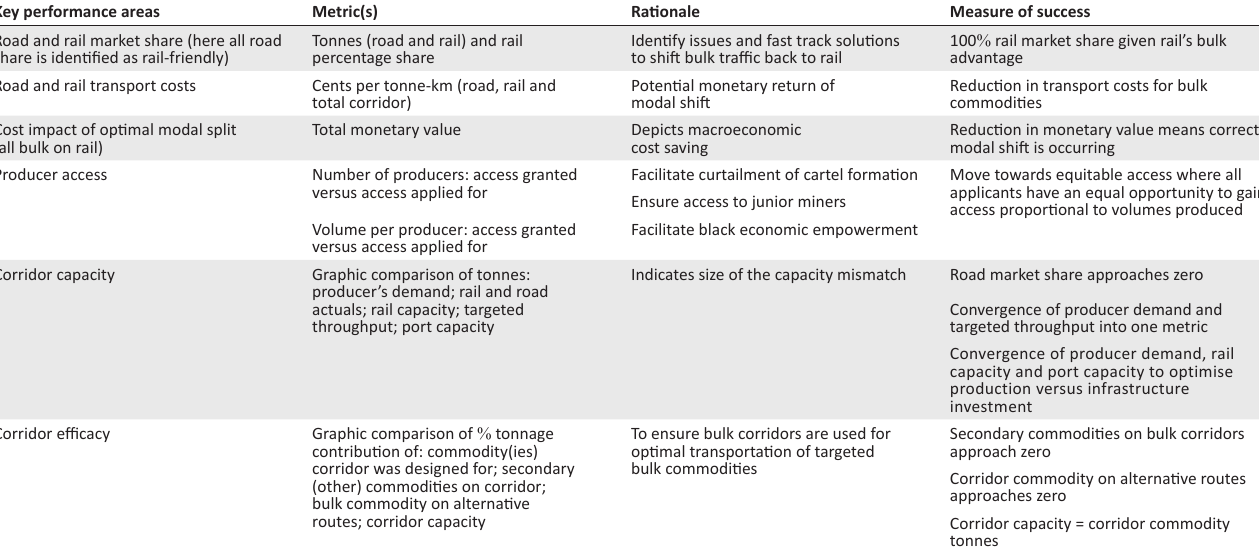
TABLE 3: Bulk export corridors – policy perspective key performance areas. Key performance areas